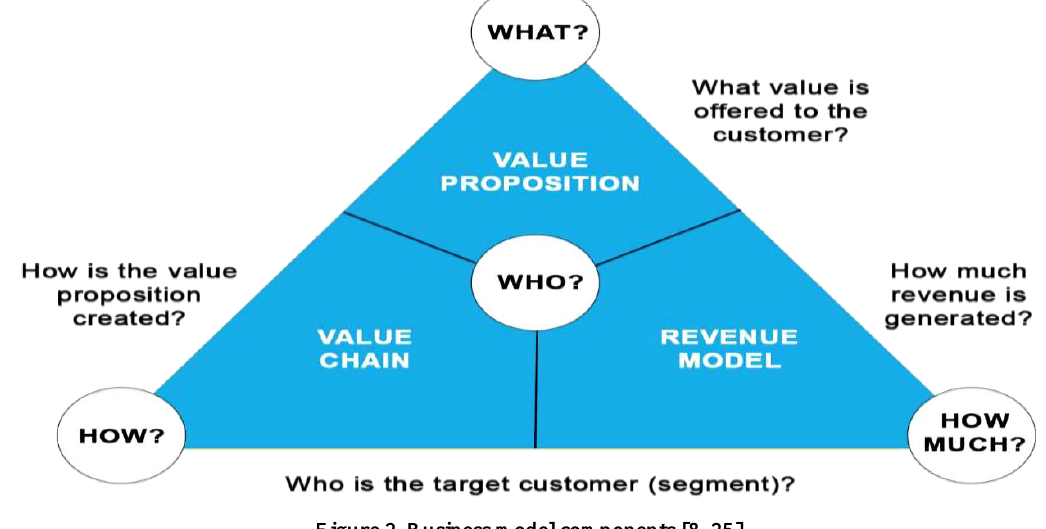
Figure 2. Business model components [8,